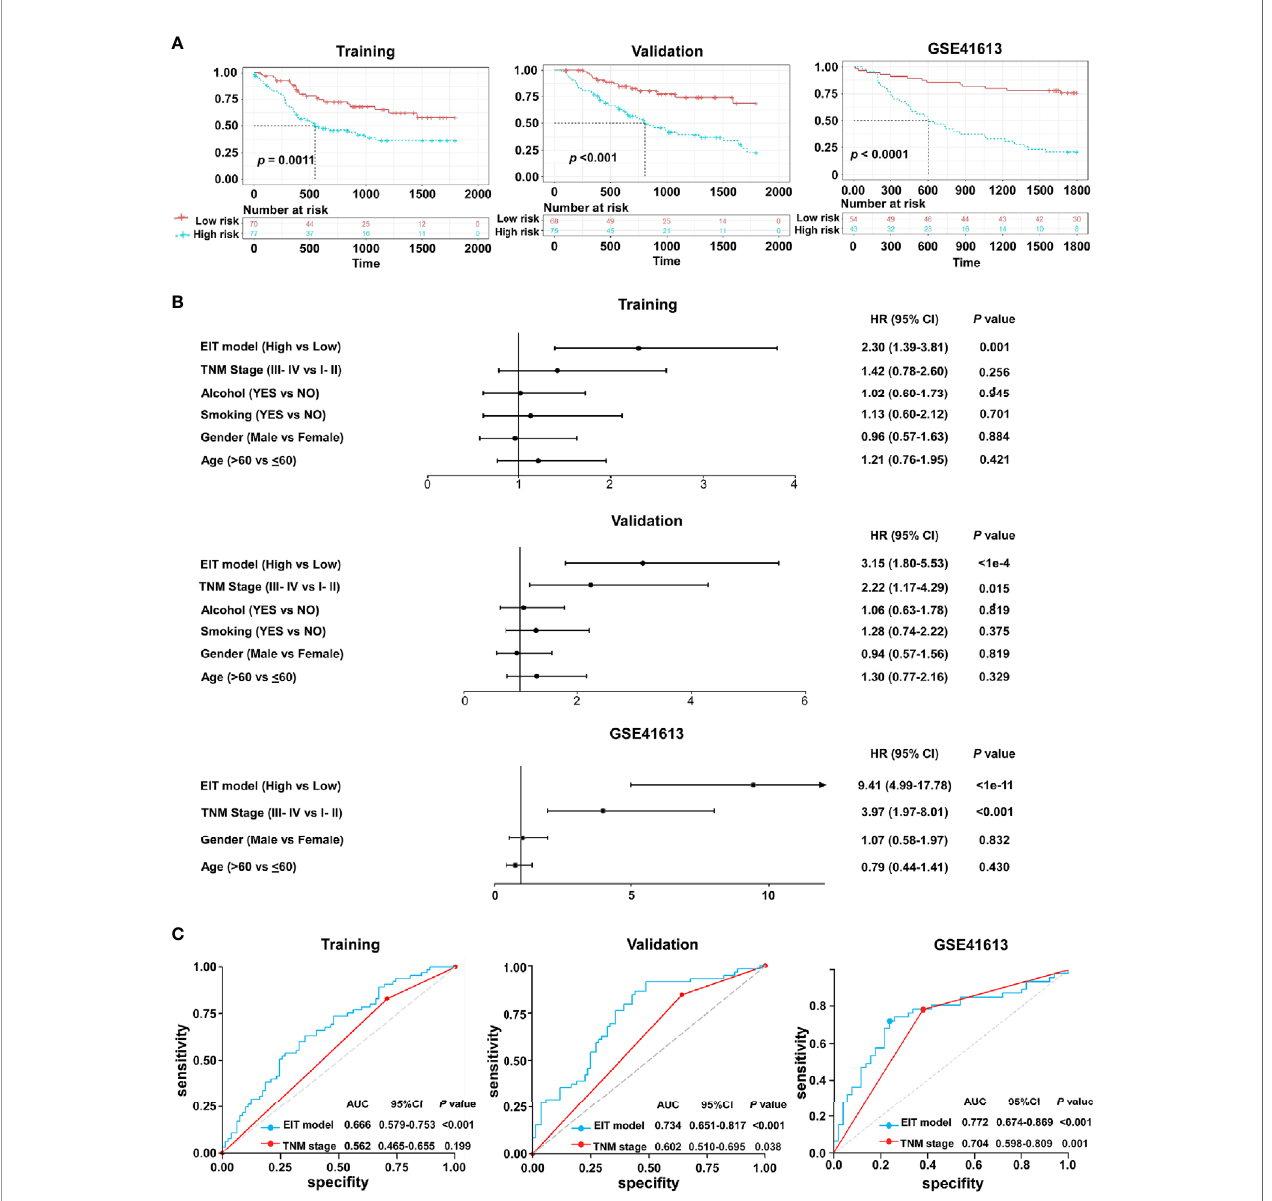
FIGURE 7 | The EIT classi fi er is a novel prognostic prediction model in OSCC. (A) The Kaplan-Meier plots of overall survival according to the EIT model. P value was calculated by log-rank test. (B) Univariate association of the EIT model and clinicopathological characteristics with overall survival. (C) The ROC curve and AUC for the EIT model and TNM